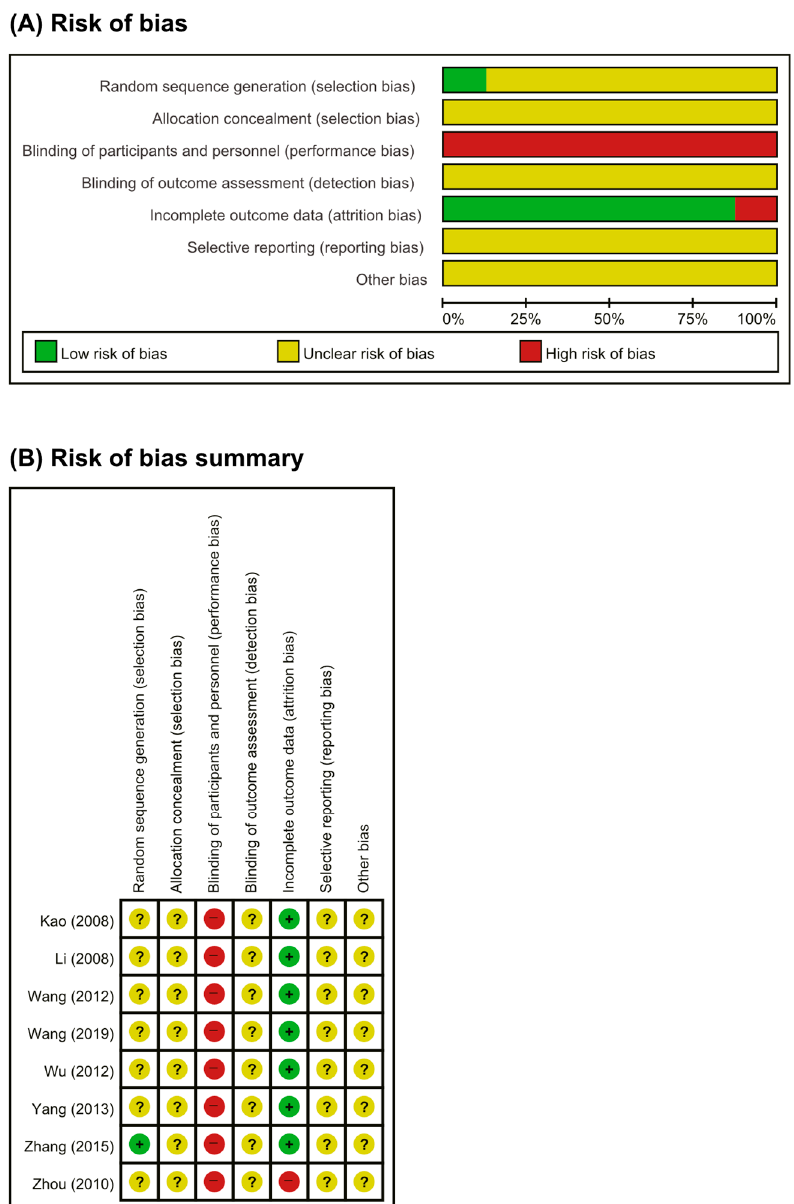
Figure 2. Risk of bias. ( A ) Risks of bias of graph: review authors’ judgments about each item’s risk of bias item presented as percentages across all included studies. ( B ) Risks of bias summary: review authors’ judgments about each item’s risk of bias for each included study. +: low risk of bias; − : high risk of bias; ?: unclear.